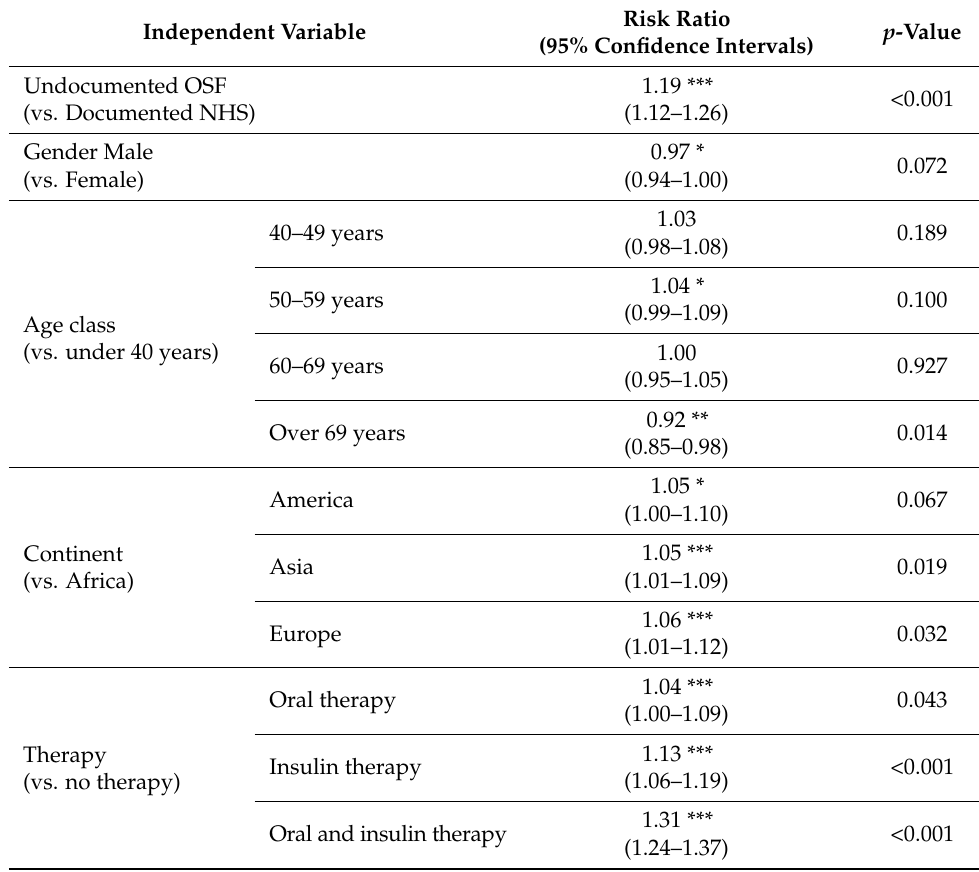
Table 2. Results from